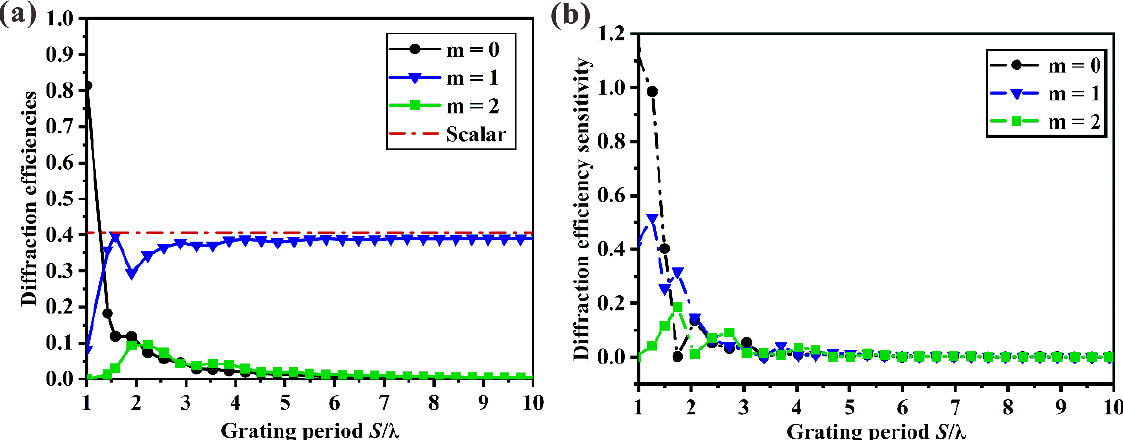
Figure 3. Comparison of the diffraction efficiency of scalar approximation and rigorous simulation for a binary grating with a duty cycle of 0.5. ( a ) Efficiencies of different orders ( m = 0, m = 1, m = 2) and ( b ) sensitivity of the efficiencies of these orders with the respect to the period. The sensitivity function is defined as ∂η m / ∂ S .